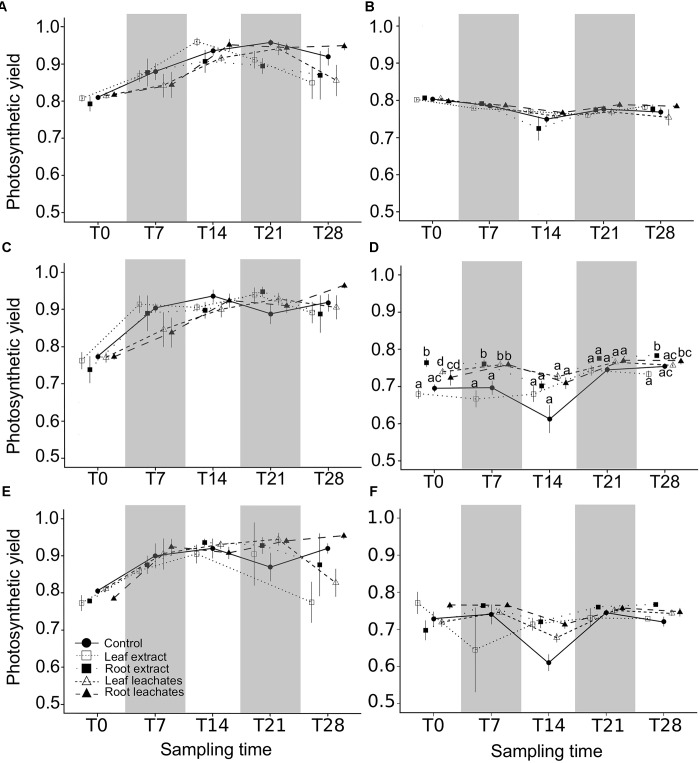
Mean photosynthetic yield plus standard error for the three species in spring and autumn: Myriophyllum aquaticum (A in spring and B in autumn), Egeria densa (C in spring and D in autumn), and Ceratophyllum demersum (E in spring and F in autumn). Treatments are denoted by white squares for leaf extract treatments, black squares for root extract treatments, white triangles for leaf leachate treatments, black triangles for root leachate treatments, and black circles for control series. Symbols marked with the same letter are not significantly different for treatment factors within the same period (p > 0.05), according to Mann–Whitney–Wilcoxon pairwise comparisons significance test adjusted by the Benjamini-Yekutieli correction.